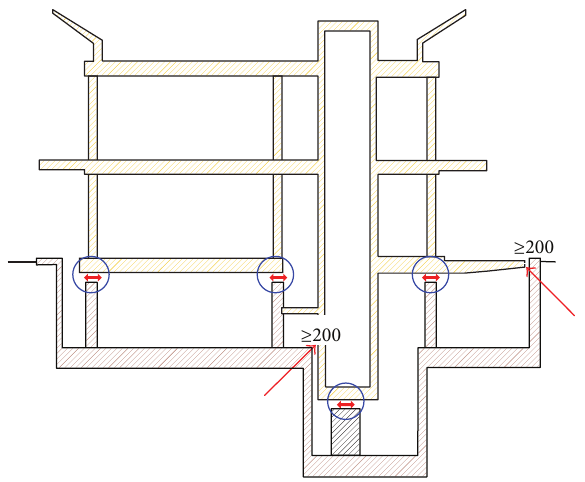
Figure 3: Schematic cross section in correspondence with the left elevator pit alignment, with isolators highlighted with circles and separation gaps between mobile and fixed structures with